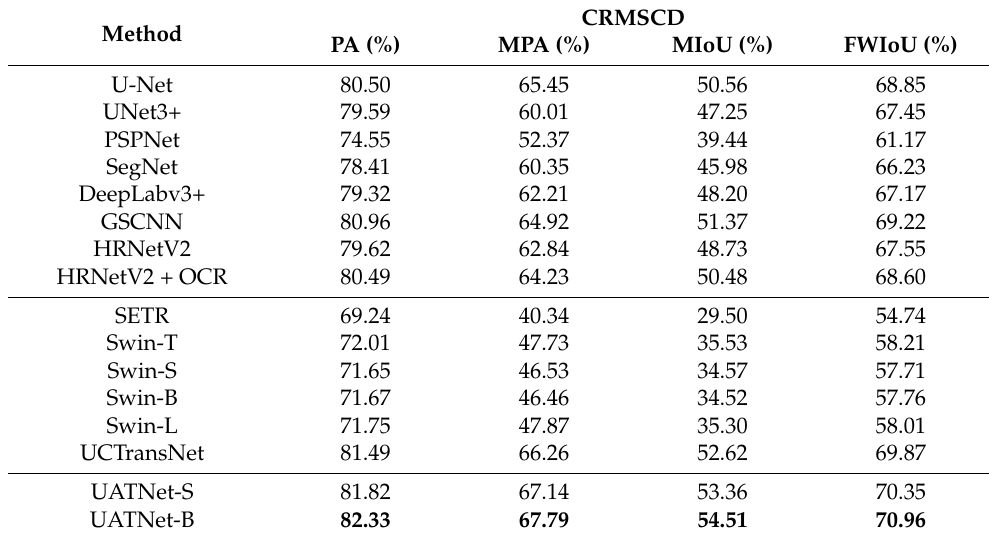
Table 8. Results of semantic segmentation on CRMSCD test set. The best results are in